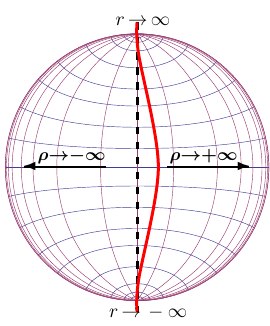
Figure 1 . Poincar(cid:19)e disc representation of the AdS 4 slicing of AdS 5 in coordinates (1.2), (1.3). Thin vertical curves are AdS 4 slices, while the horizontal curves correspond to slices of constant r . The black dashed line shows the AdS 4 slice wrapped by the D5 brane for massless (cid:13)avors, while the thick solid red curve schematically shows an embedding for massive (cid:13)avors. embeddings for AdS and S 3 defects as compared to a (cid:13)at R 1 ; 2 defect (for which massive 3 embeddings have been discussed already in